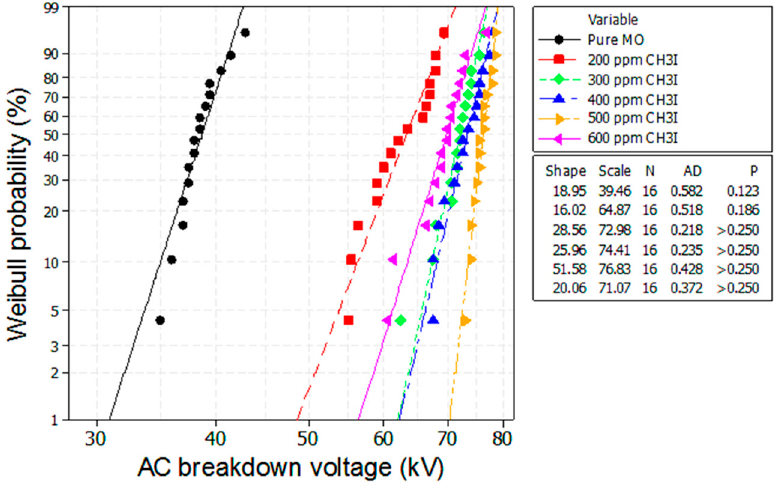
Figure 7. Weibull plot of the breakdown voltage of the mineral oil with various concentrations of the CH 3 I scavenger additive.